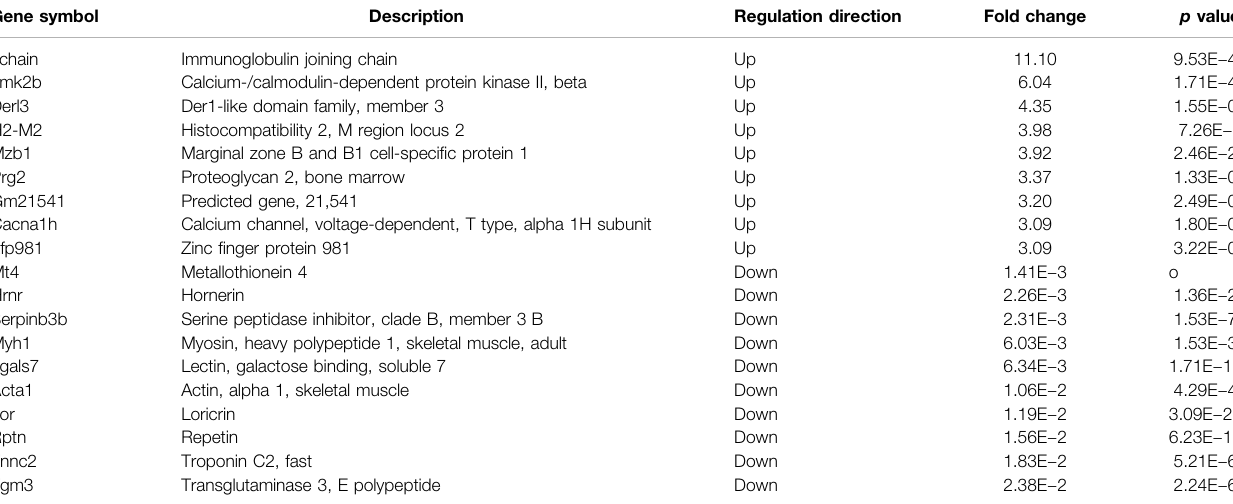
TABLE 1 | Detailed information of the top 10 up-regulated and top 10 down-regulated mRNAs. Gene symbol Description Regulation direction Fold change p value Jchain Immunoglobulin joining chain Up Calcium-/calmodulin-dependent protein kinase II, beta Up Der1-like domain family, member 3 Up Histocompatibility 2, M region locus 2 Up Marginal zone B and B1 cell-speci fi c protein 1